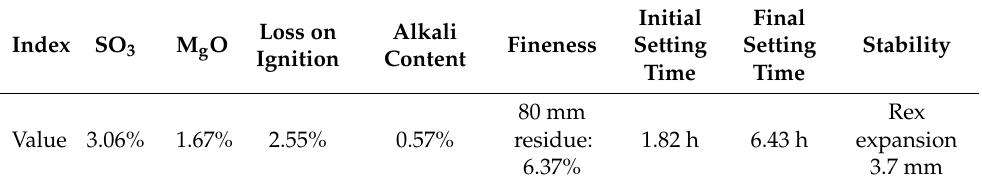
Table 4. Mix proportions of RAC and SFRAC. Table 2. Physical properties of P.O. 42.5R cement used in the